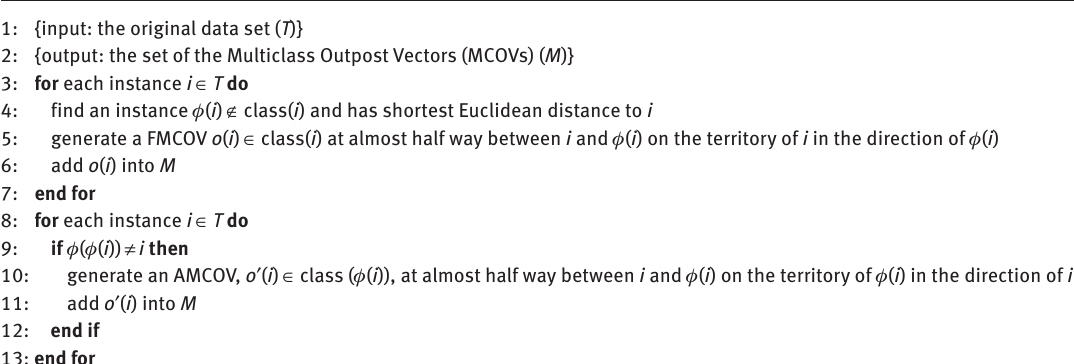
Algorithm 1 The Multiclass Outpost Vector Generation Algorithm